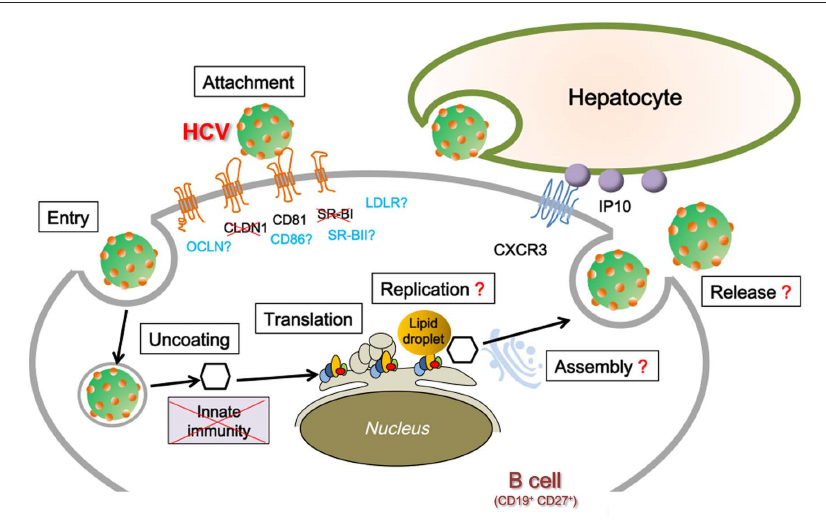
Figure 1 | Proposed lifecycle of HCV in B cell. The life cycle of the hepatitis C virus (HCV) has several specific steps. Virus entry is mediated by the direct interaction of envelope glycoproteins with co-receptors, presumably E2–CD81 binding. CLDN1 and SR-BI are not expressed in B cell. Innate immunity response against HCV is suppressed by HCV infection. Some HCV-encoding proteins, i.e., core and NS3, have been proven to be expressed in B cells. HCV RNA replication was examined by nested PCR and in situ hybridization. Mechanisms of virus assembly, vesicle fusion, and virion release in B cell remain unknown. LDLR, low-density lipoprotein receptor; SR-BI, scavenger receptor class B type I; SR-BII, scavenger receptor class B type II; CLDN1, claudin-1; OCLN, occludin; CXCR3, chemokine (C-X-C motif) receptor 3; IP-10, interferon gamma-induced